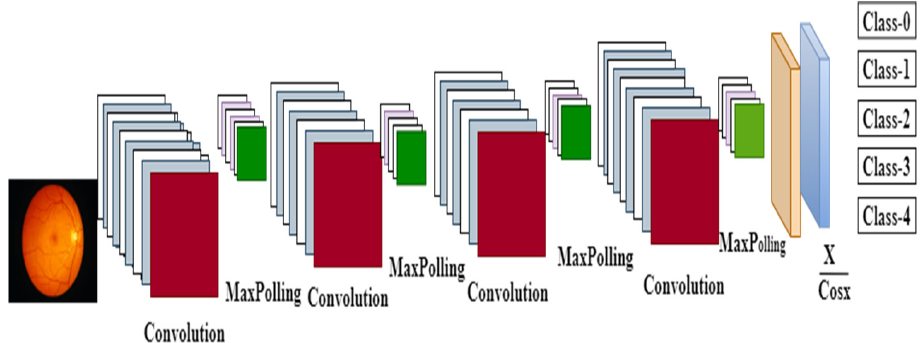
Figure 3. CNN with improved activation function.